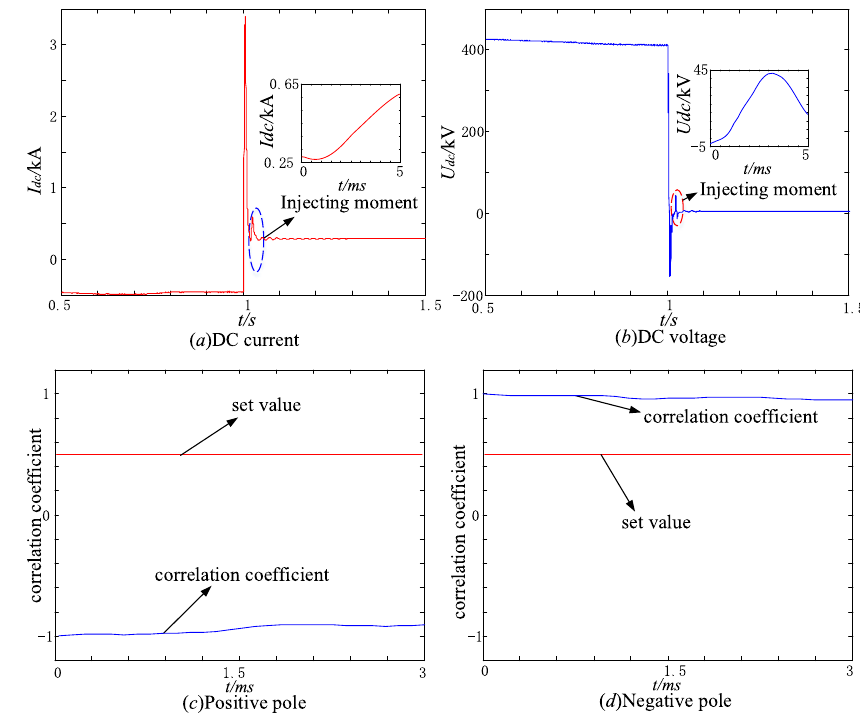
Fig. 11 f 1 point pole-to-ground fault